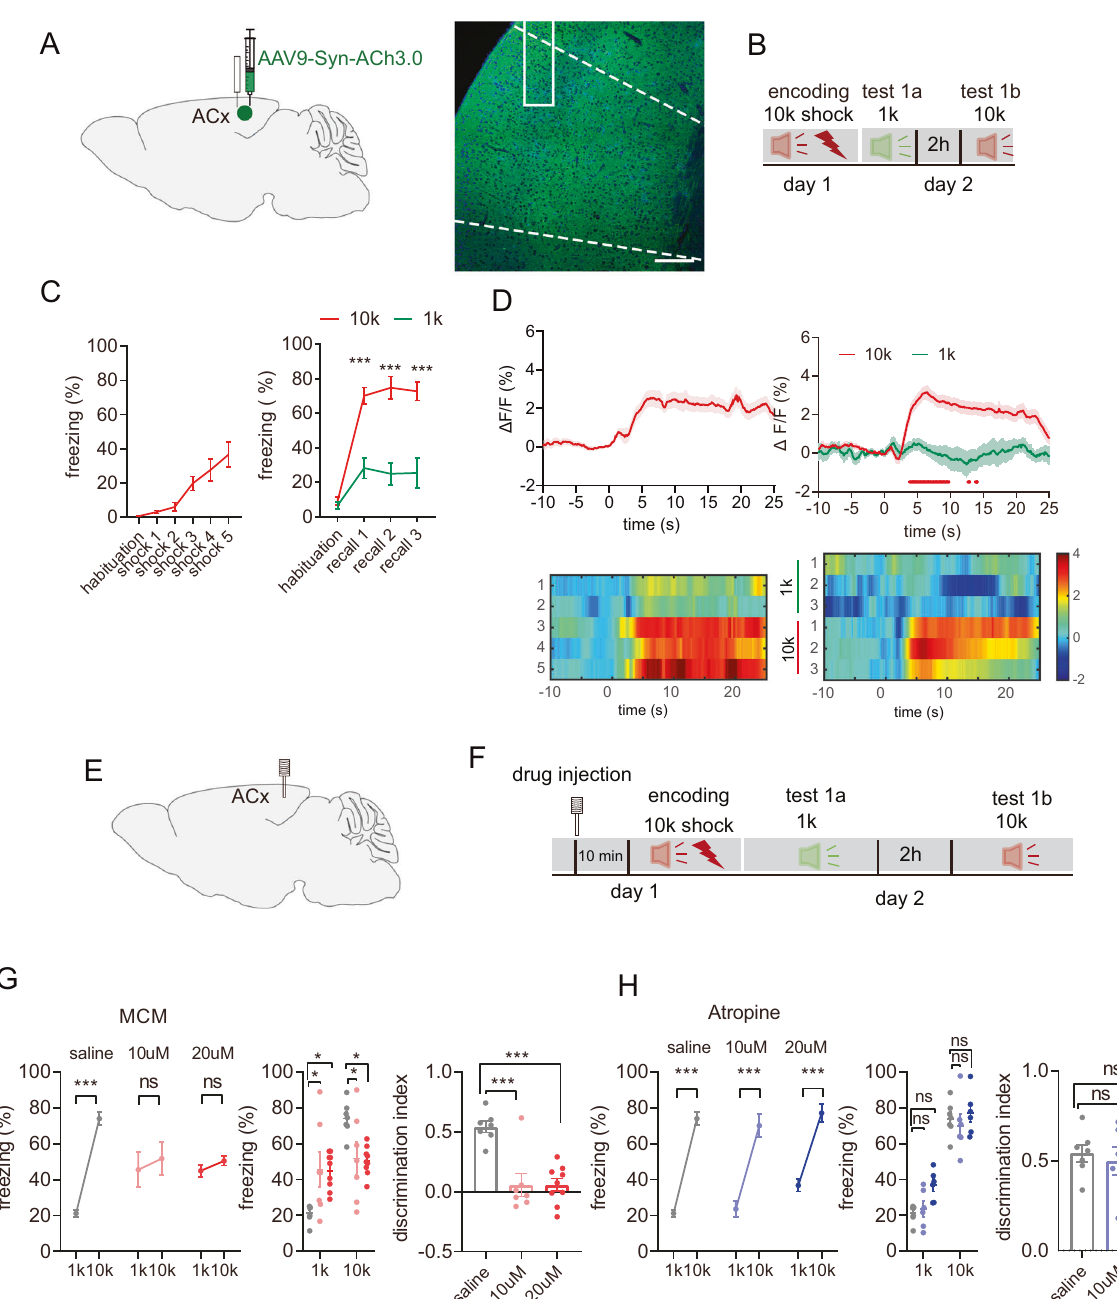
Fig. 1 The ACh signaling in the ACx participates in the DAFM via nAChR. A Schematic of virus injection of AAV9-Syn-ACh3.0 and representative confocal images of ACh3.0 expression in the ACx (blue: DAPI; green: ACh3.0) Scale bar: 200 μ m. B Behavioral design. C The behavioral performances on day 1 and day 2 (right, F (3, 48) = 7.588, P < 0.001, n = 7). D The mean and SEM of the fl uorescence responses of ACh3.0 in the ACx of mice at day 1 (left) and day 2 (right) and their corresponding heatmaps. The red line indicated bins between the 10k and 1k trials with two-tailed unpaired t-test signi fi cance ( P < 0.05). E Schematic of bilateral cannulas injection. F Behavioral design. G Percentage of the freezing time (left, middle) and the discrimination index (right) in mice under the treatment of nAChR blocker mecamylamine (MCM) in the ACx at the encoding stage (saline, n = 7; 10 µM, n = 6; 20 µM, n = 6; freezing: F (2, 40) = 11.24, P < 0.001; discrimination index: F (2, 20) = 16.65, P < 0.0001). H Percentage of the freezing time (left, middle) and the discrimination index (right) in mice under treatment of mAChR blocker Atropine in the ACx at the encoding stage (saline, n = 7; 10 µM, n = 7; 20 µM, n = 9; freezing: F (2, 40) = 11.24, P < 0.001; discrimination index: F (2, 16) = 2.337, P = 0.13). Statistical tests: ( C , G , and H ) freezing: two-way ANOVA with Bonferroni ’ s multiple comparisons tests. G , H discrimination index: one-way ANOVA with Bonferroni ’ s multiple comparisons tests. ns not signi fi cant; * P < 0.05, ** P < 0.01, *** P < 0.001. Data are presented as mean ±